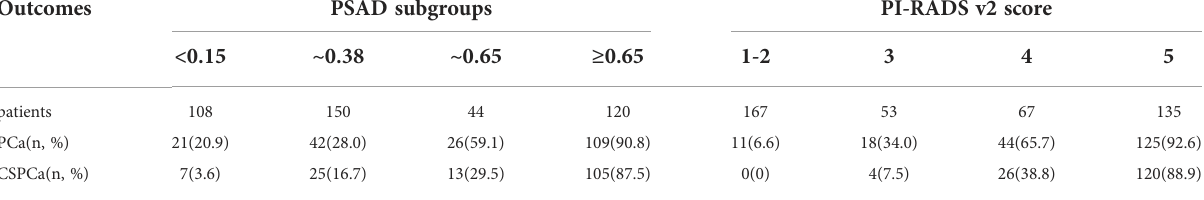
TABLE 5 Detection of PSAD subgroups and PI-RADS v2 score for PCa and CSPCa. Outcomes